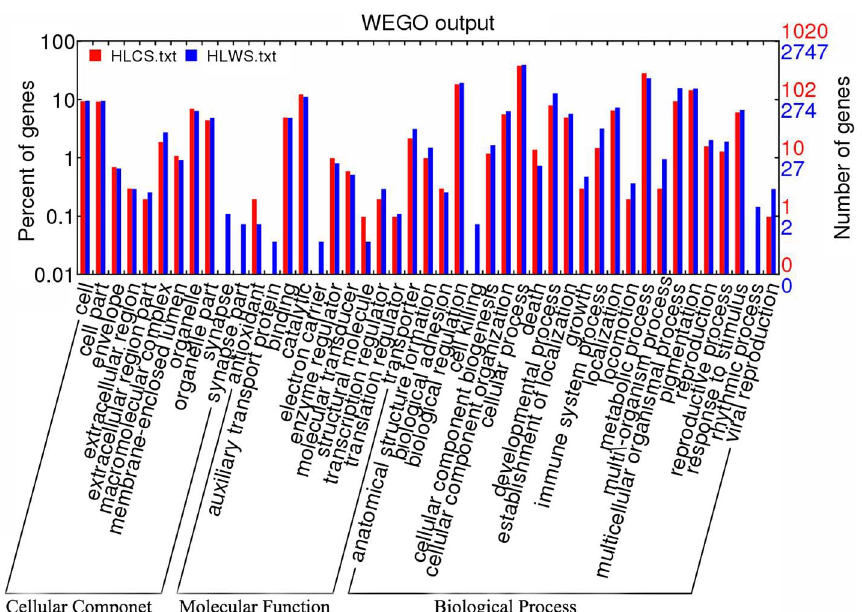
Figure 3. Partial GO classi fi cation annotated by gene2go for predicted target genes. The fi gure shows partial GO enrichment for the predicted target genes in terms of cellular components, molecular functions, and biological